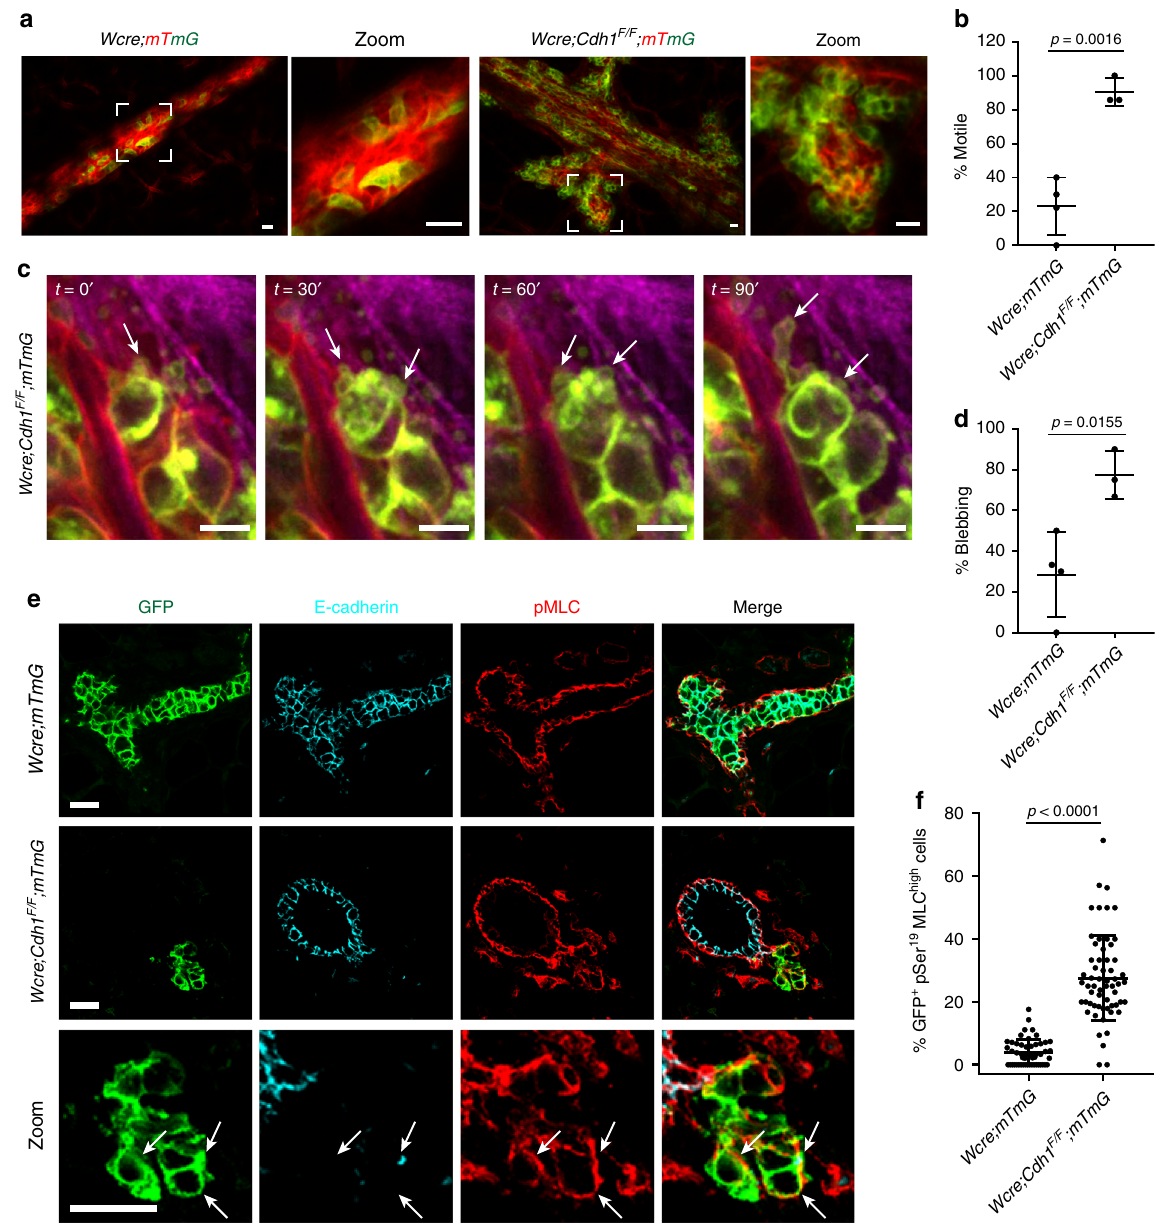
Fig. 2 E-cadherin loss increases actomyosin contractility. a Still images derived from in vivo intravital imaging of the mammary gland of 8-week-old Wcre; mTmG and Wcre;Cdh1 F/F ;mTmG mice displaying GFP-positive Cre-switched MMECs and mTomato non-switched MMECs and stromal cells. Zooms reveal motile GFP-positive E-cadherin inactivated MMECs in Wcre;Cdh1 F/F ;mTmG mice. Scale bars, 20 µ m. b Quanti fi cation of the percentage of GFP-positive motile cells among Wcre;mTmG ( n = 2) and Wcre;Cdh1 F/F ;mTmG ( n = 3) mice. Data are of four and three images per group, respectively. c Still image of in vivo intravital imaging of Wcre;Cdh1 F/F ;mTmG mice demonstrates extensive cell blebbing of GFP-positive E-cadherin inactivated MMECs. Scale bar, 10 µ m. d Quanti fi cation of the percentage of GFP-positive blebbing cells among Wcre;mTmG ( n = 2) and Wcre;Cdh1 F/F ;mTmG ( n = 3) mice. Data are of four and three images per group, respectively. e Examination of myosin light chain (MLC) activity by IF analysis of pSer 19 MLC in GFP-positive E-cadherin- de fi cient MMECs in 5-month-old Wcre;mTmG and Wcre;Cdh1 F/F ;mTmG mice. Scale bar, 20 µ m. f Quanti fi cation of the amount of GFP + pSer 19 MLC high cells Wcre;mTmG ( n = 3) and Wcre;Cdh1 F/F ;mTmG ( n = 3) mice. Data are of 51 and 60 images, respectively. All data are depicted as mean ± standard deviation. All p values were calculated using an unpaired two tailed t -test. Source data are provided as a Source Data fi